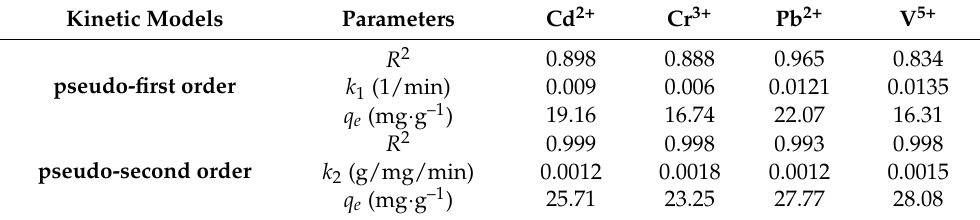
Table 1. Kinetic models and parameters for selected heavy metal ions.